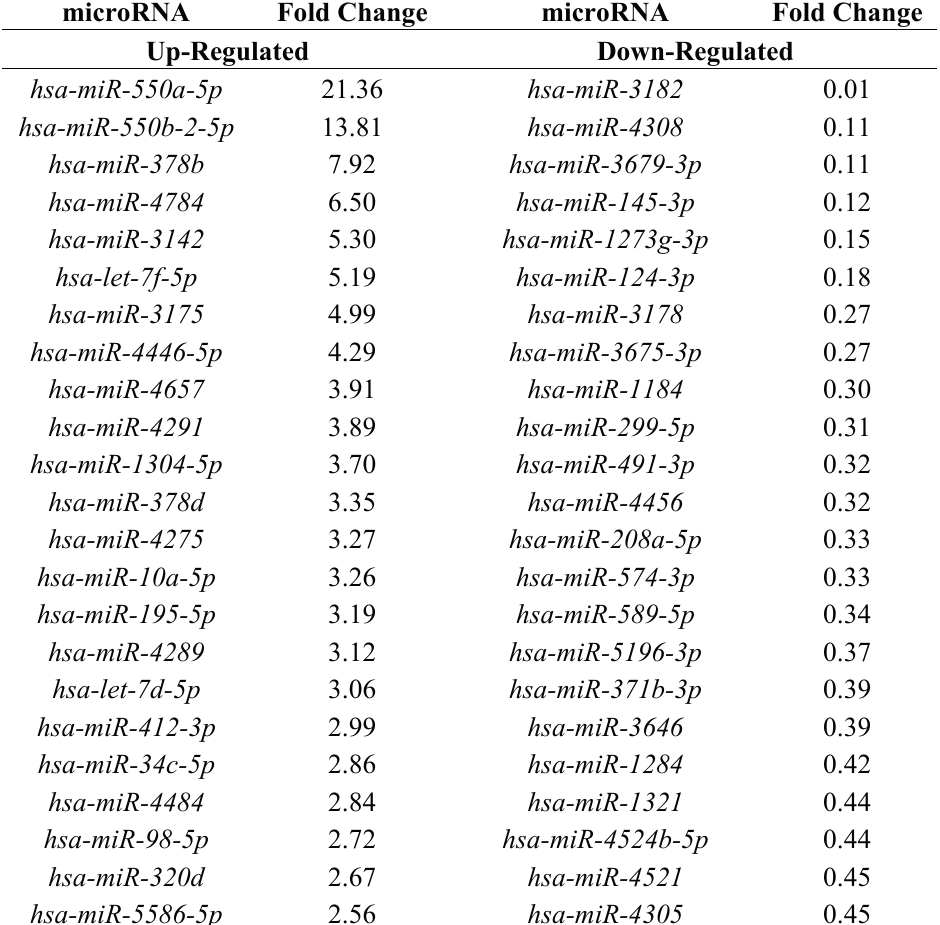
Table 1. Listing of differentially expressed miRNAs in the microarray